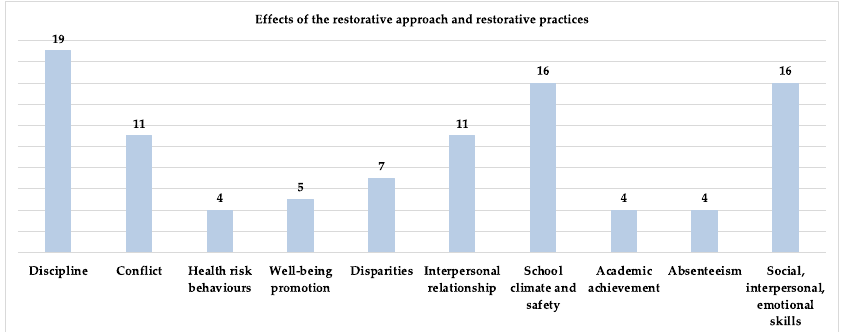
Figure 4. Effects of the restorative approach and restorative practices.